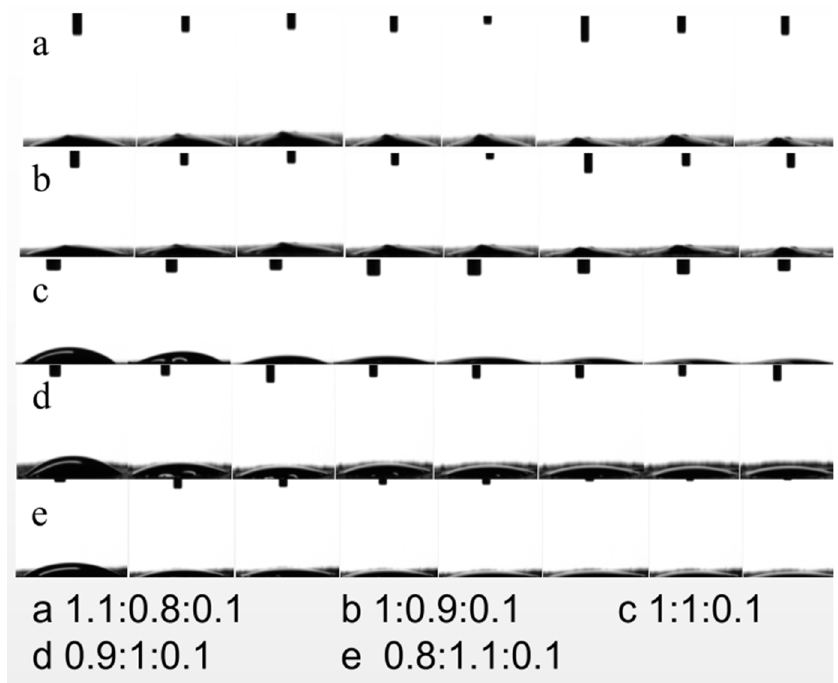
Figure 4. Dynamic contact angle of different monomer ratios (BA/MMA/AA).